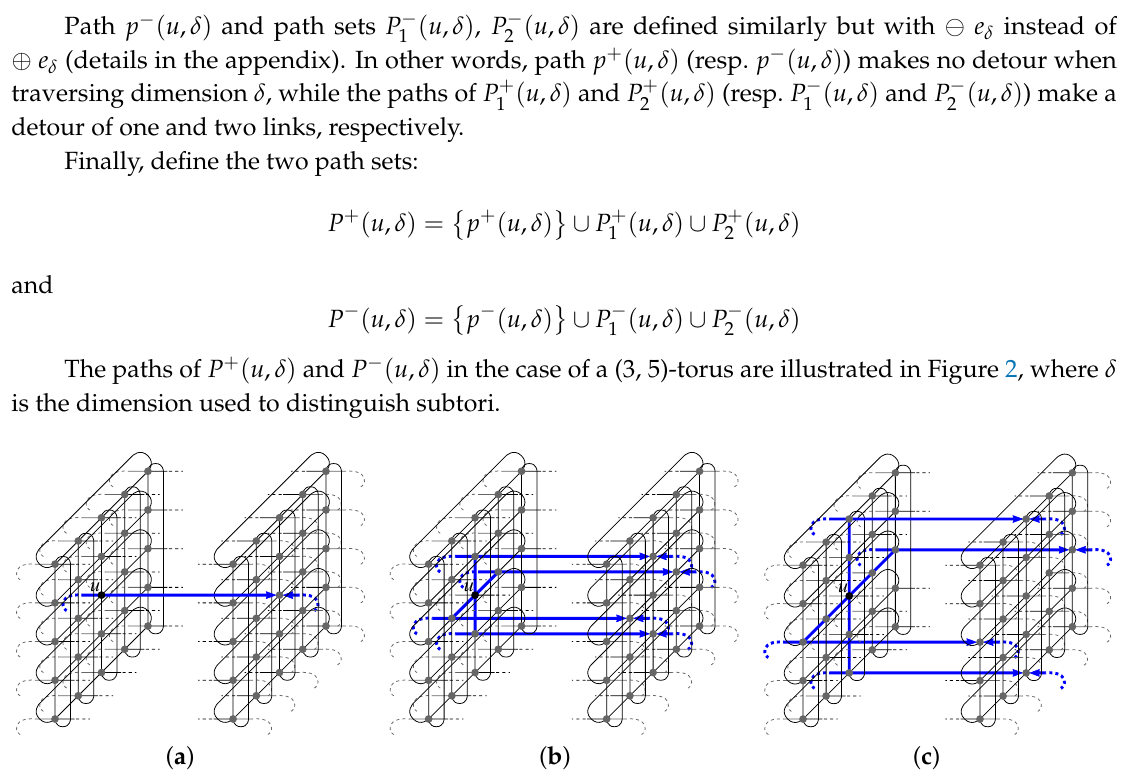
( u , δ ) , P + ( u , δ ) and ( c ) P − ( u , δ ) , P + ( u , δ ) 2 2 1 1